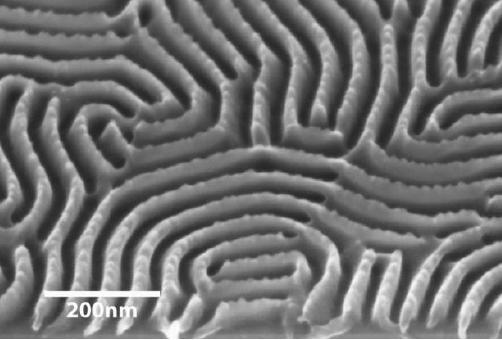
Figure 8. Roughness features observed on the top surface of the freestanding lamellar PS structure after PMMA removal in block copolymer lithography have comparable dimensions to those on full film PS